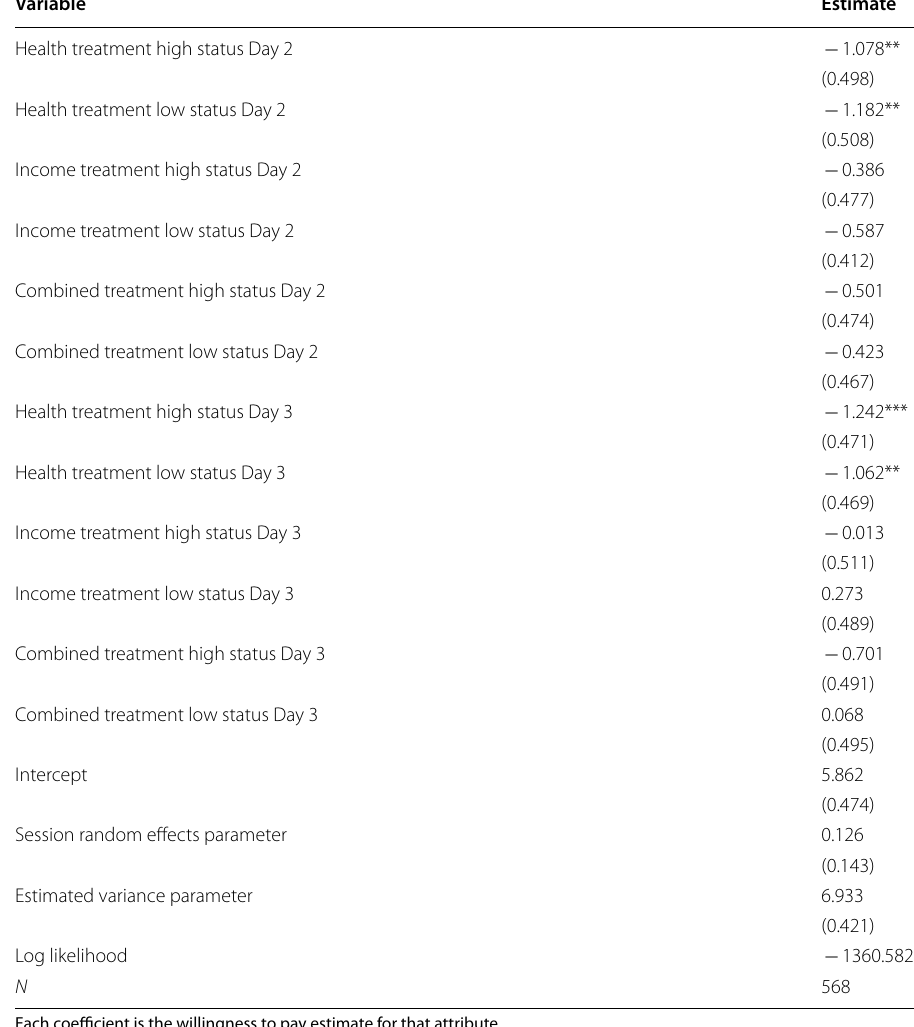
Table 3 Multilevel mixed-effects results for willingness to pay based on treatment and